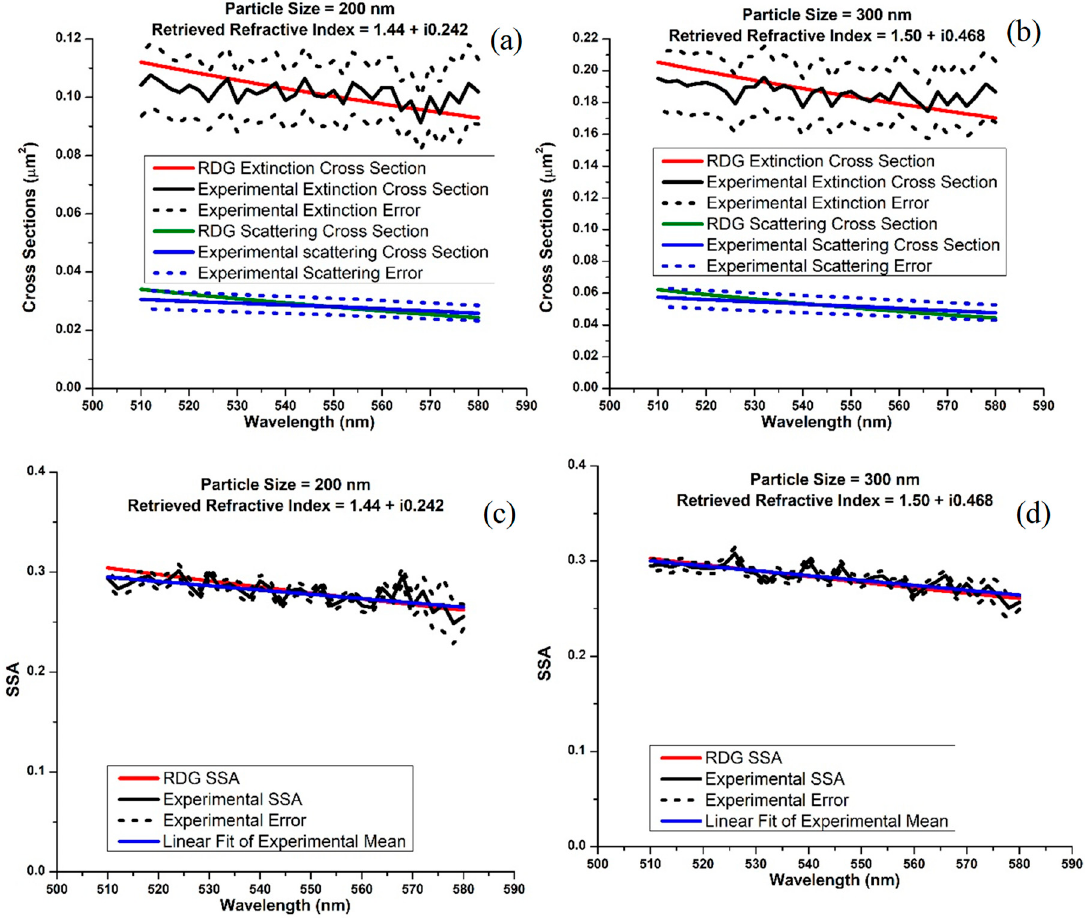
Figure 6. Comparison of measured and calculated cross sections and SSA values for olive fuel. Subfigures show ( a ) the cross sections for 200 nm size particles, ( b ) the cross sections for 300 nm size particles, ( c ) the SSA for 200 nm size particles, and ( d ) the SSA for 300 nm size particles.